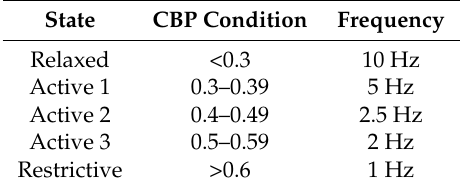
Table 1. Configuration of CBP and frequency values to the